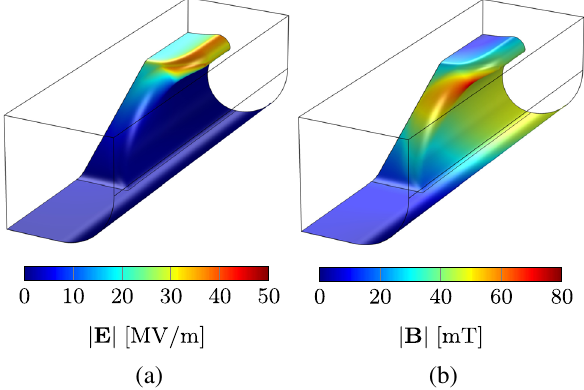
FIG. 3. Eighth of the inner cavity surface. The electric (a) and magnetic (b) field distributions of the TE 111 -like fundamental mode is scaled to the nominal deflecting voltage of V 3 ⊥ ; 0 ¼